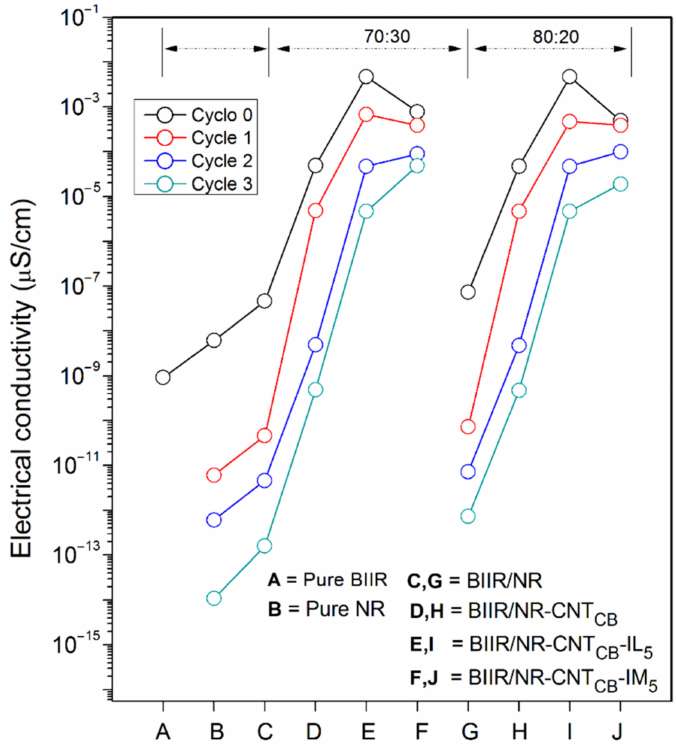
Figure 13. Electrical conductivity of pure rubbers and their composites with and without IL and IM modifiers, BIIR:NR ratios of 70:30 and 80:20 after recycling from 1, 2, and 3 rounds using the compression molding of 10,000